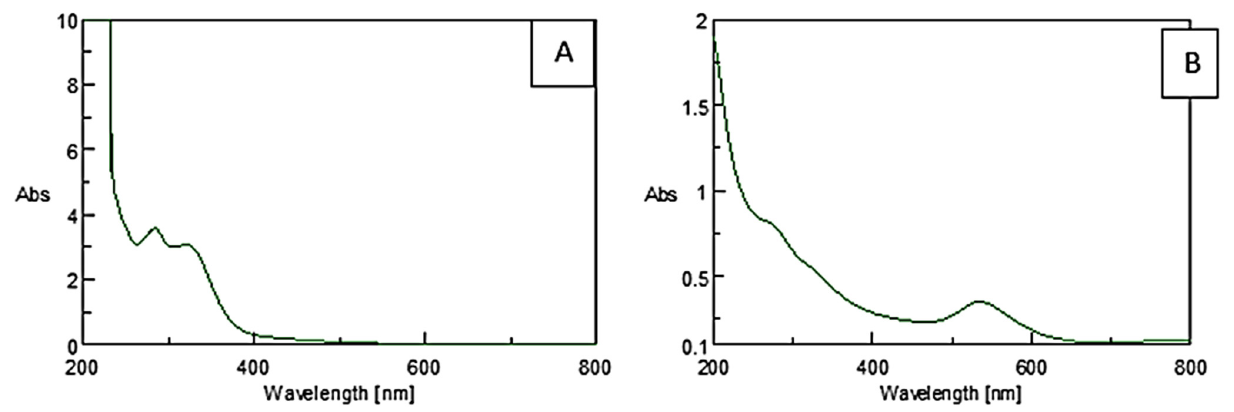
Figure 3. UV-Vis spectra of ( A ) plant extract and ( B ) AuNPs synthesized using M. piperita .